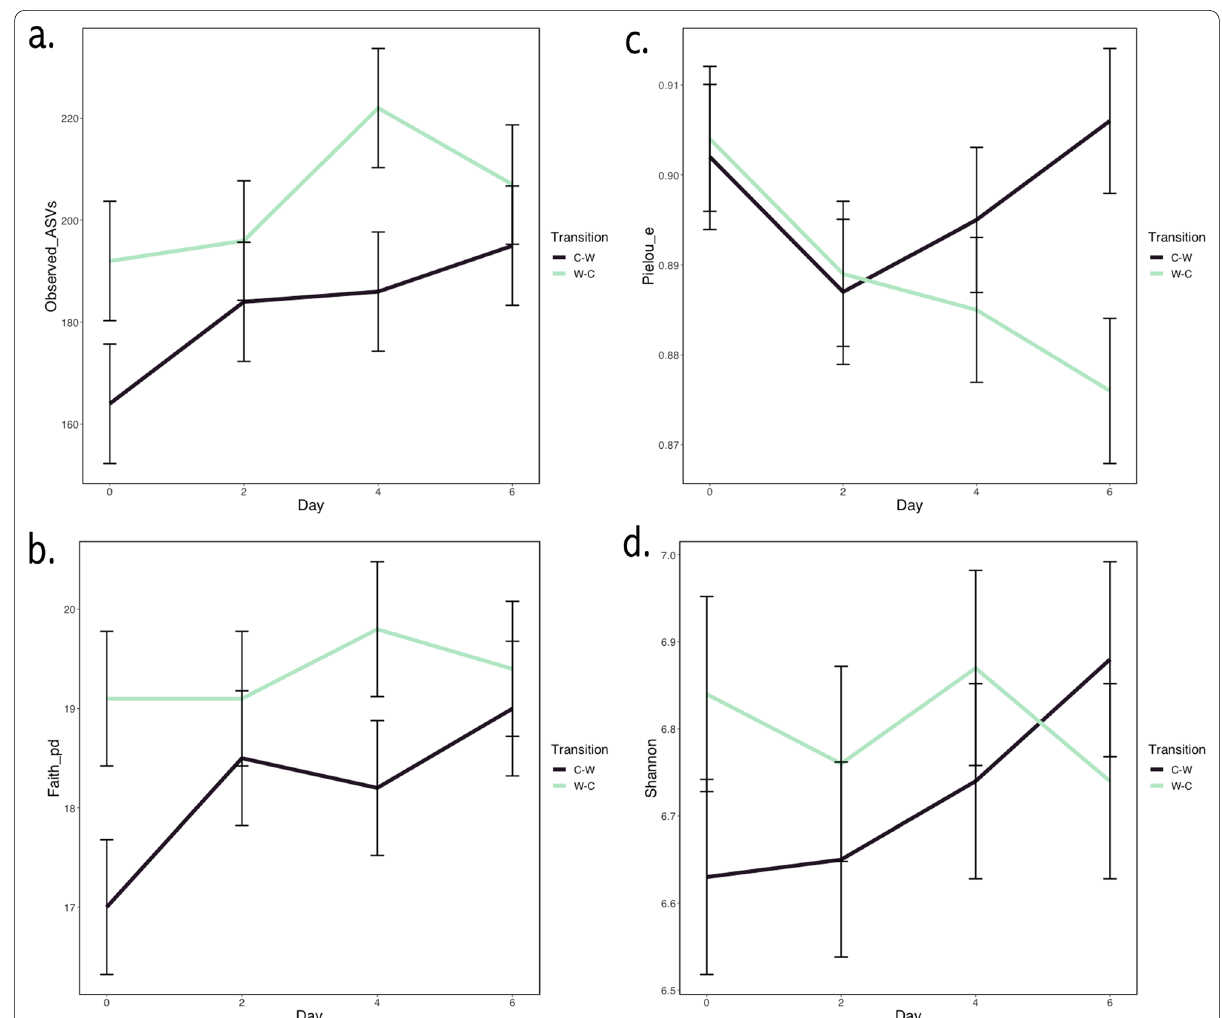
Fig. 1 Fecal microbiota α‑diversity following transitions between cool‑season and warm‑season grass. Metrics including a Observed ASVs (richness) b Pielou’s Evenness, c Shannon Diversity Index, and d Faith’s Phylogenetic Diversity were analyzed by mixed model ANOVA with Tukey’s post hoc adjustment for transitions from cool‑season grass to warm‑season grass (C–W) and warm‑season grass to cool‑season grass (W–C). There was an effect of day and transition for Observed ASVs ( P < 0.02). There was an effect of transition ( P 0.0015), but not for Faith’s Phylogenetic Diversity. = Shannon Diversity and Pielou’s Evenness did not differ by transition or day, and there were no significant interactions between any of the main effects for any of the metrics